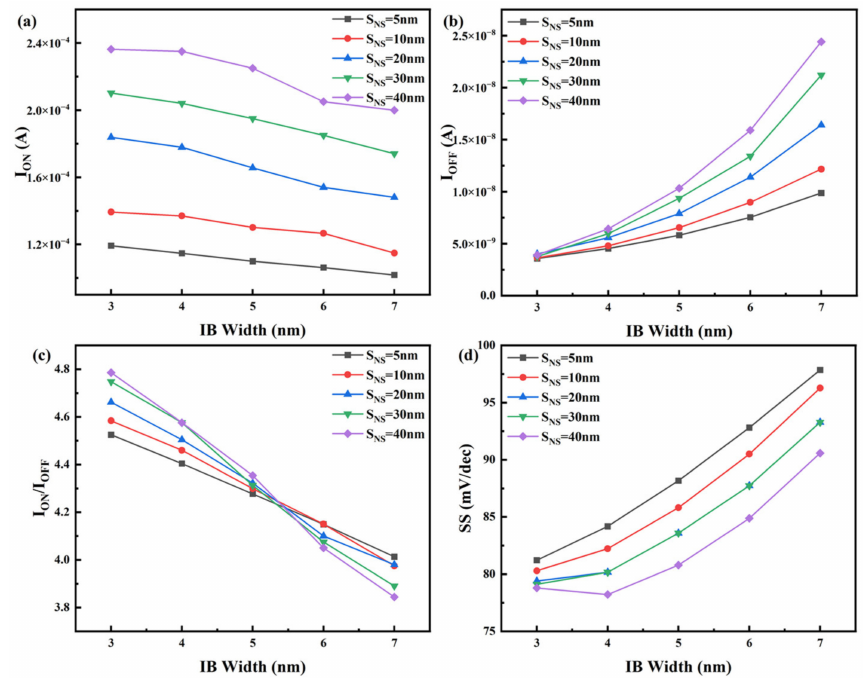
Figure 3. Impact of W IB : ( a ) I ON ; ( b ) I OFF ; ( c ) I ON /I OFF ; ( d ) SS of the TreeFET with different S NS at V GS = V DS = 0.7 V and W NS = 20 nm at V GS = V DS = 0.7